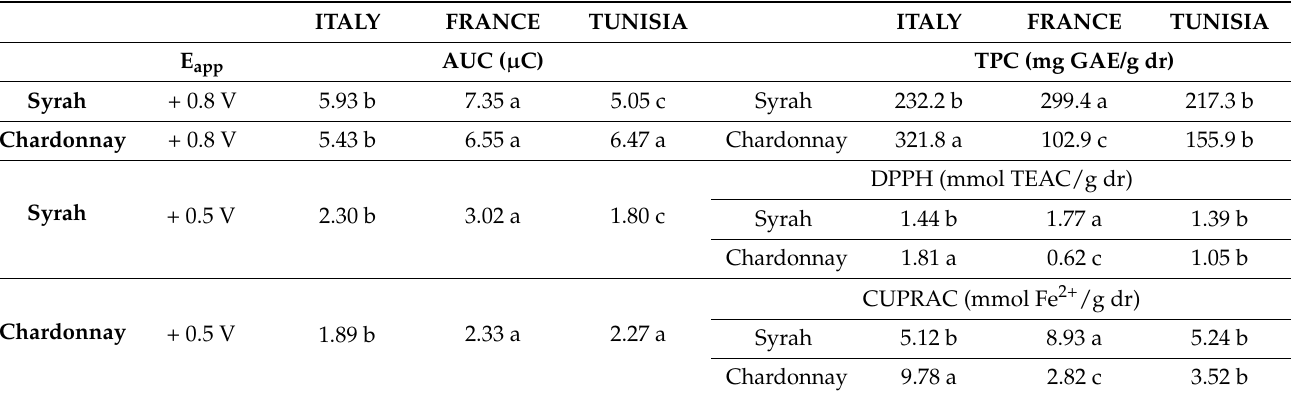
Table 1. Area under curve of CVs of Syrah and Chardonnay pomace extracts, total polyphenol content measured by Folin–Ciocalteu, and AAox measured by DPPH and